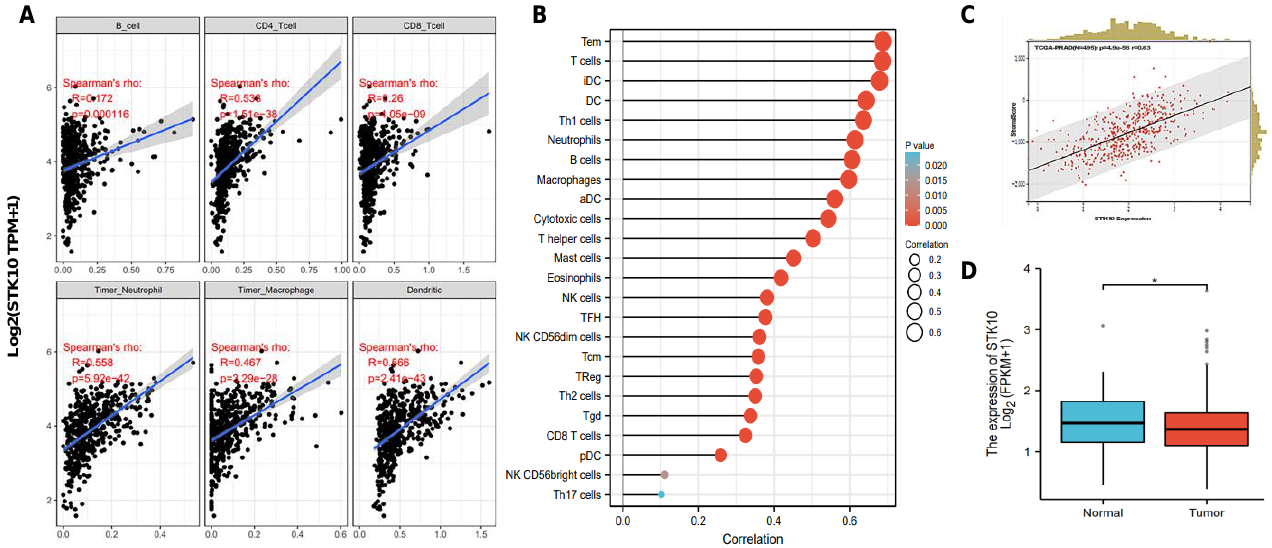
Figure 1. STK10 was associated with the infiltrated immune cells in prostate cancer. ( A ) The expression of STK10 showed significant positive correlations with B cells, CD4 + T cells, CD8 + T cells, neutrophils, macrophages and dendritic cells in the TME of PRAD. ( B ) Lollipop plots show the correlations between the STK10 expression level and the relative abundances of 24 types of immune cells in PRAD samples from the TCGA dataset. ( C ) The expression correlation of STK10 with stromal score in PRAD samples from the TCGA dataset. ( D ) The expression level of STK10 was significantly up-regulated in adjacent normal tissues compared to that in the tumor tissues. * p < 0.05.